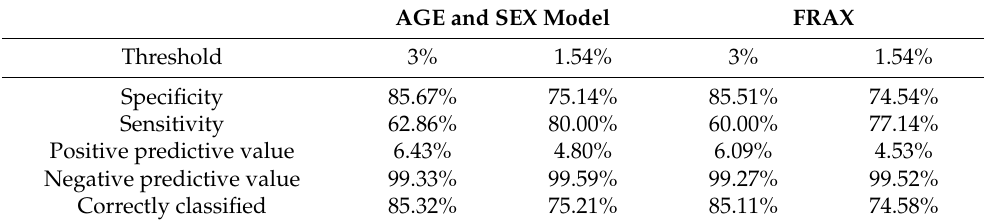
Table 3. Comparison of discriminatory measures using the 3% and the 1.54% thresholds.